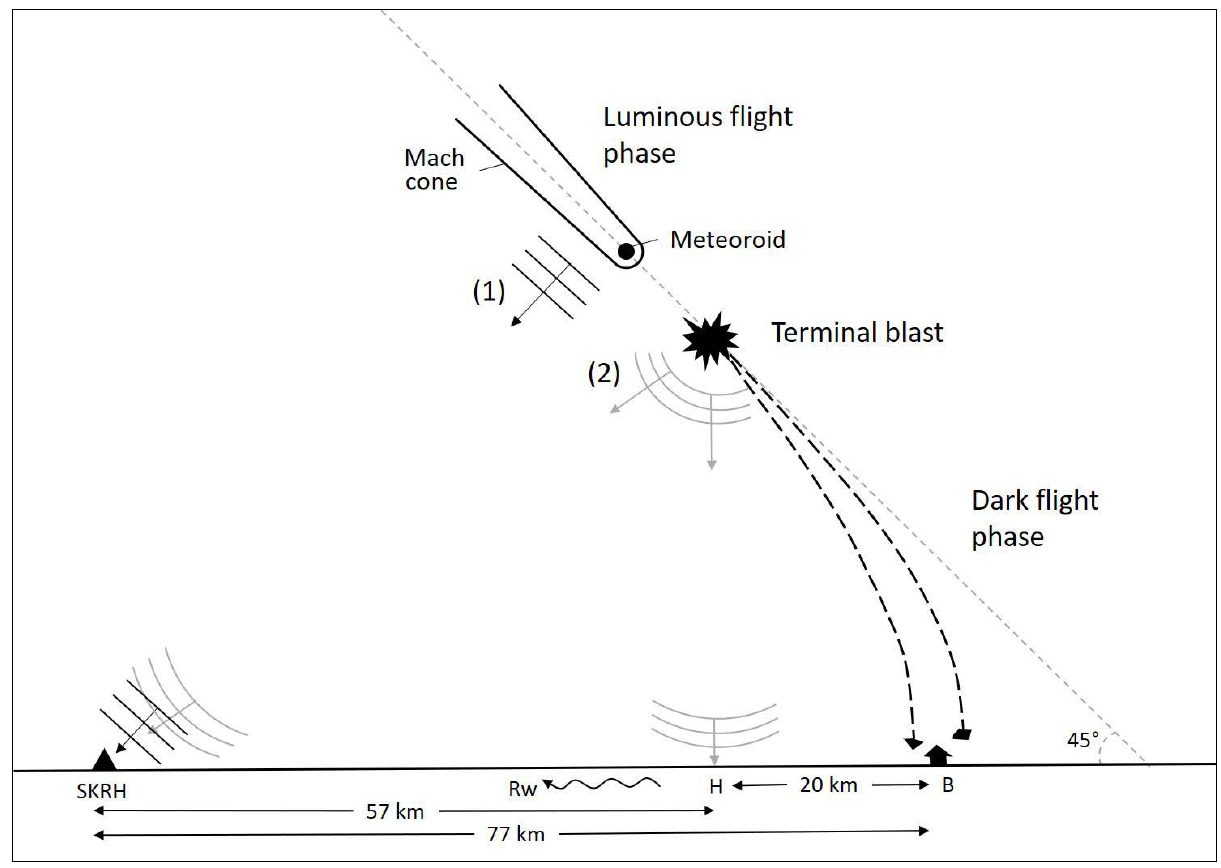
Figure 5: Model solution for the bolide-induced signal received at SKRH station (see Figure 4), involving a bolide travelling at a 45° angle and a terminal burst at 40 km altitude, 20 km north-northwest of Benenitra (B). The atmospheric pressure waves triggered by the bolide during hypervelocity flight (1) and/or the terminal burst (2) couple directly with the surface at the recording site (SKRH), but they arrive after the air-coupled Rayleigh waves (Rw). The latter are created when the acoustic waves of the terminal burst (2) couple with Earth’s surface at the hypocentre (H) to form ground seismic waves which then propagate outwards. Because the velocity of the seismic waves in rocks is far higher (3–5 km/s) than in air (0.343 km/s), the air-coupled Rayleigh waves arrive before the direct